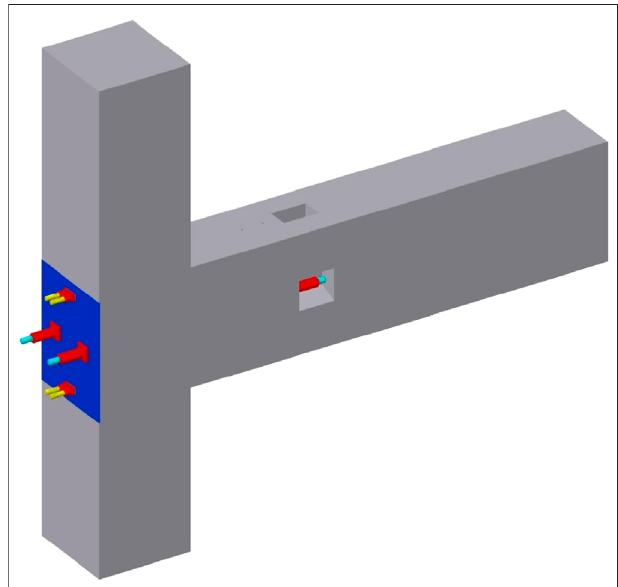
FIGURE 1 | Connection detail of post-tensioned precast